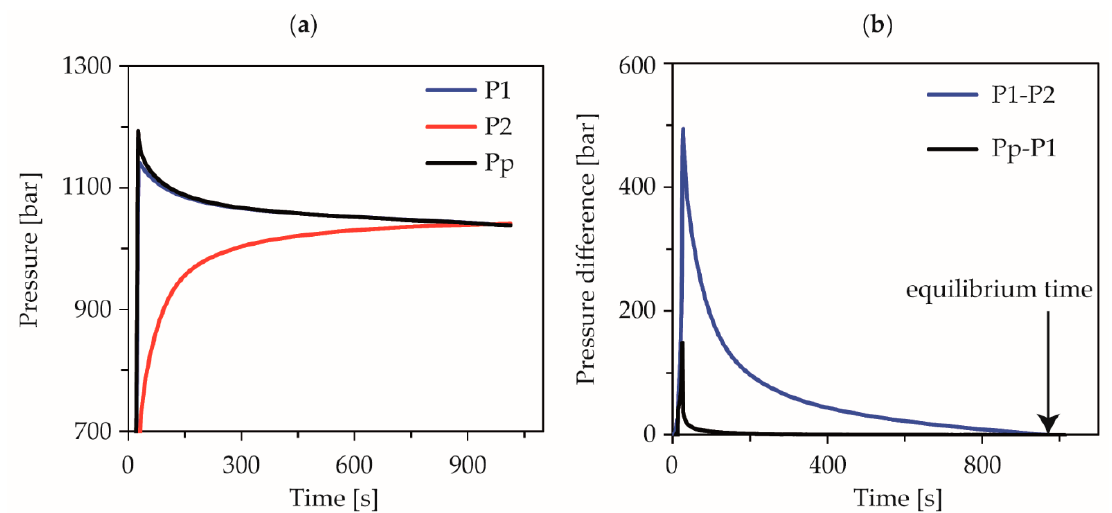
Figure 2. Course of the pressure signals after piston stop ( a ) and evaluation of the pressure difference between measuring chamber and counter-pressure chamber to determine the equilibrium time ( b ).